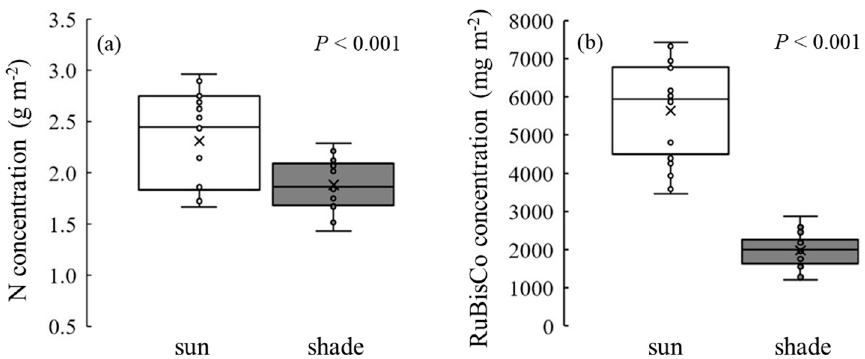
Figure 1. ( a ) N and ( b ) RuBisCo contents in sun and shade leaves of Robinia pseudoacacia . Values represent mean ± SE. ANOVA was used to test the difference between the leaf position at the 0.05 alpha level.